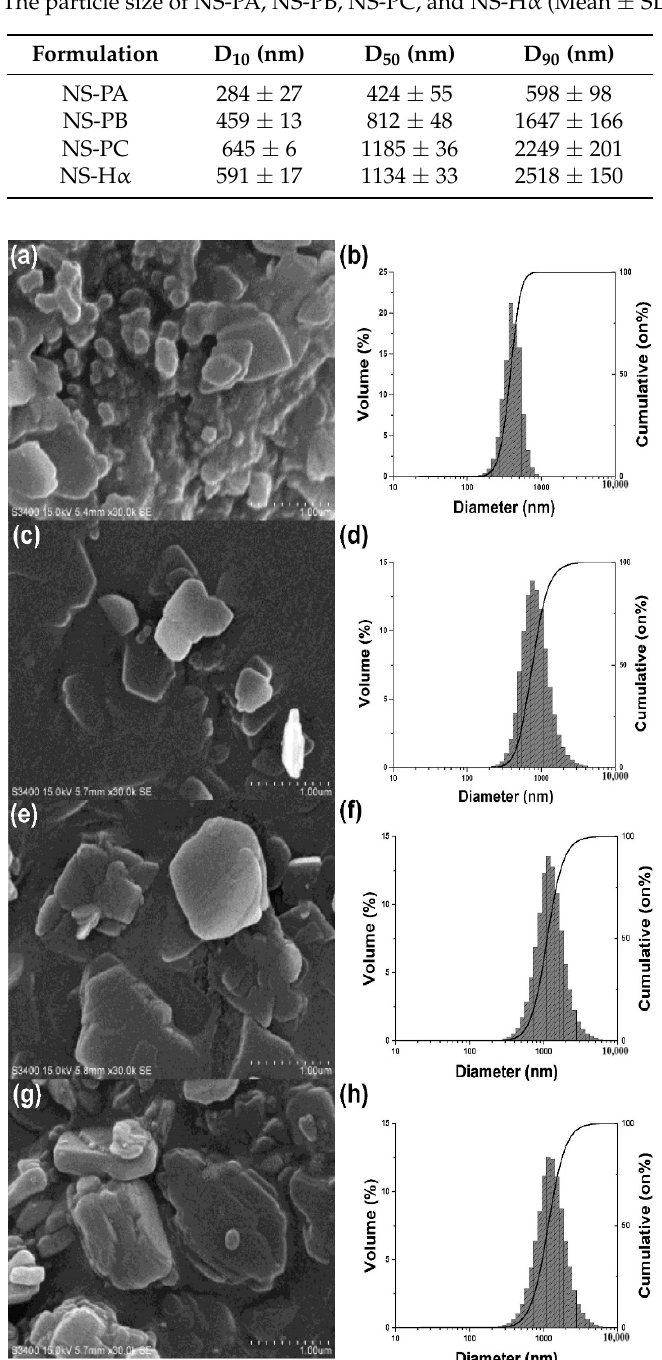
Table 1. The particle size of NS ‐ PA, NS ‐ PB, NS ‐ PC, and NS ‐ H α (Mean ± SD, n = 3).